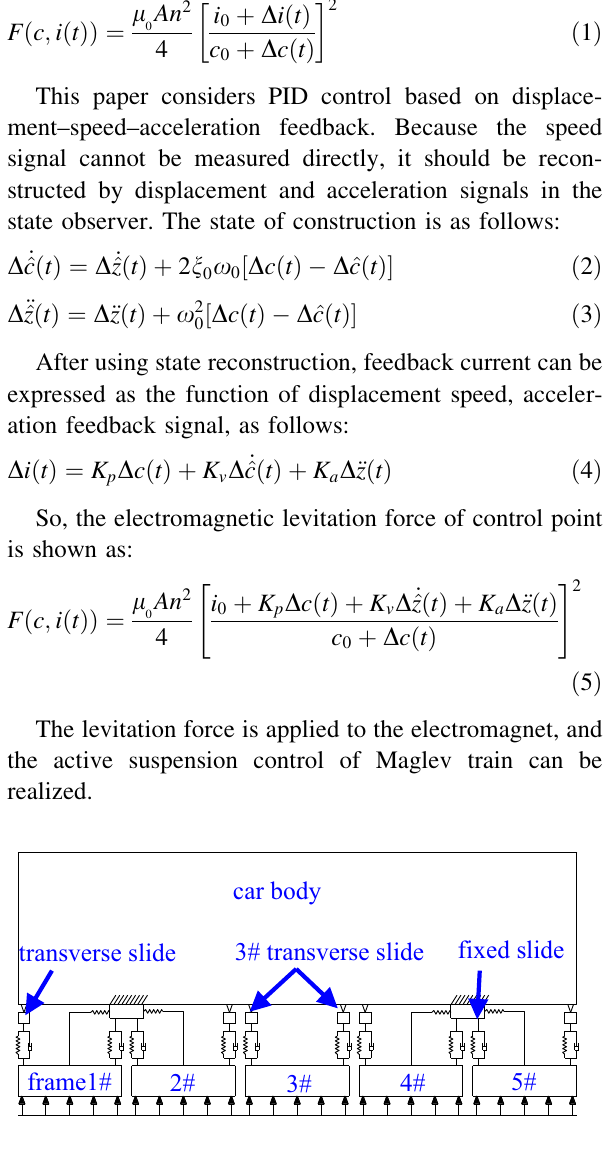
Fig. 1 Suspension of five modules L _ M -speed Maglev